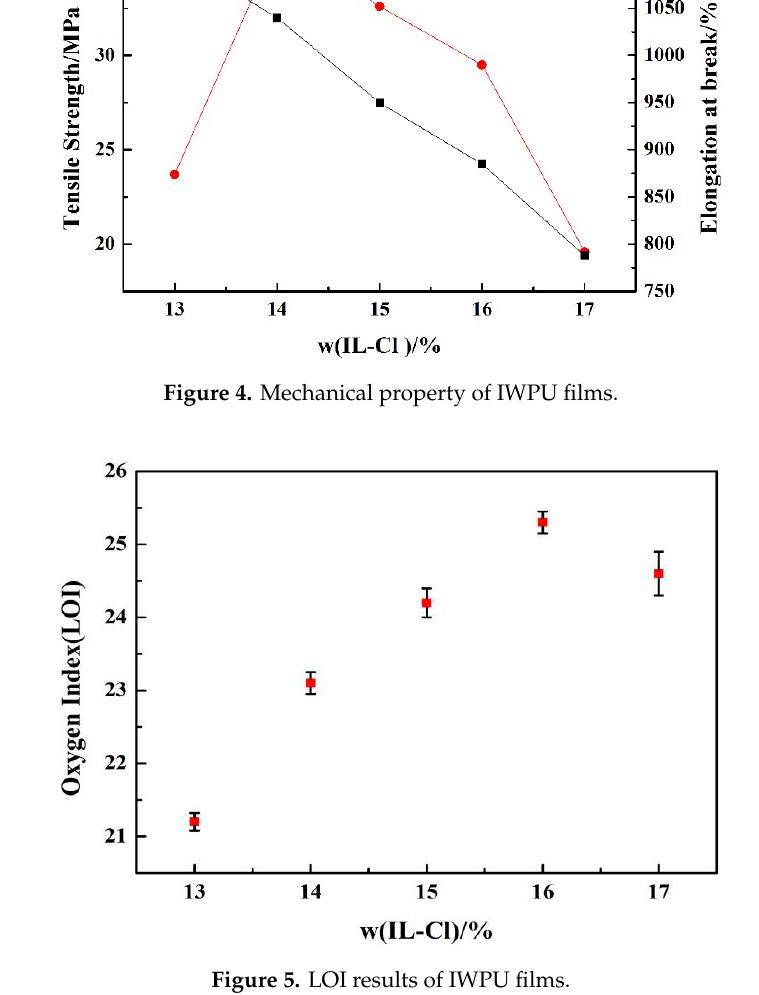
Figure 6. Ionic conductivity results of the IWPU films. Table 7. Ionic conductivity values of IWPU films.